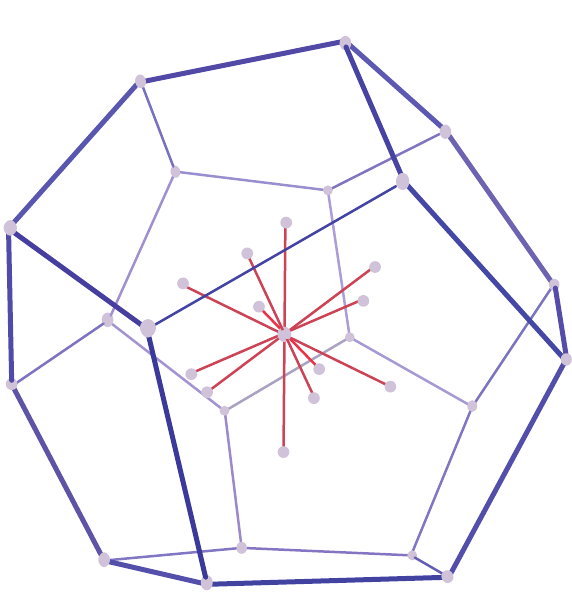
Figure 5: The vectors 𝑋 1 ,...,𝑋 12 .